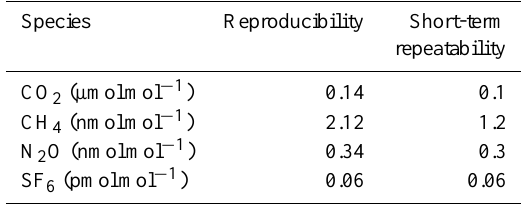
Table 5. Reproducibility and typical short-term (24h) repeatability of the GC system at Puy de Dôme, both within 1